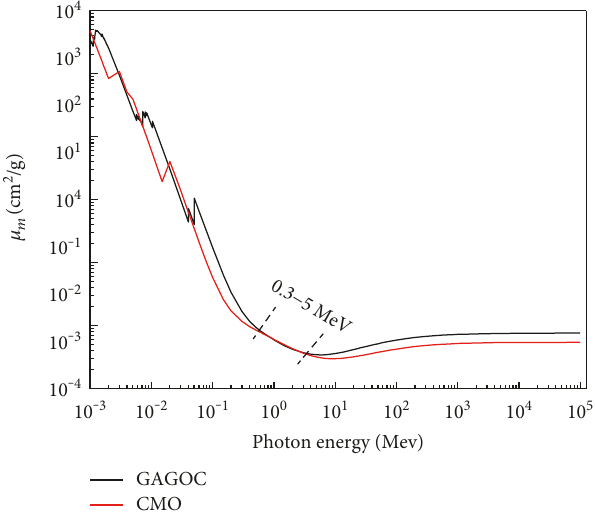
Figure 2: Variation of total mass attenuation coe ffi cients versus incident photon energy for GAGOC and